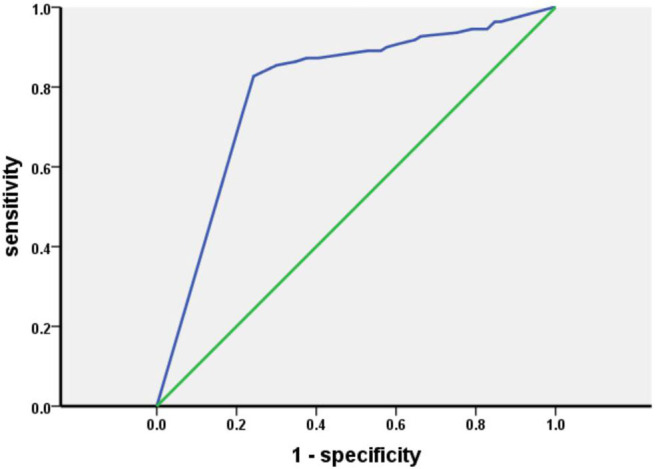
ROC curve for the HRS.